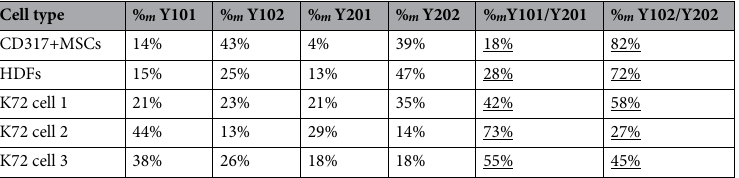
Table 1. Cell-type matches (% m ) obtained from a KNN model where the closest-distance match between PIR- means in each hTERT MSC panel have been accounted for and then determined across all